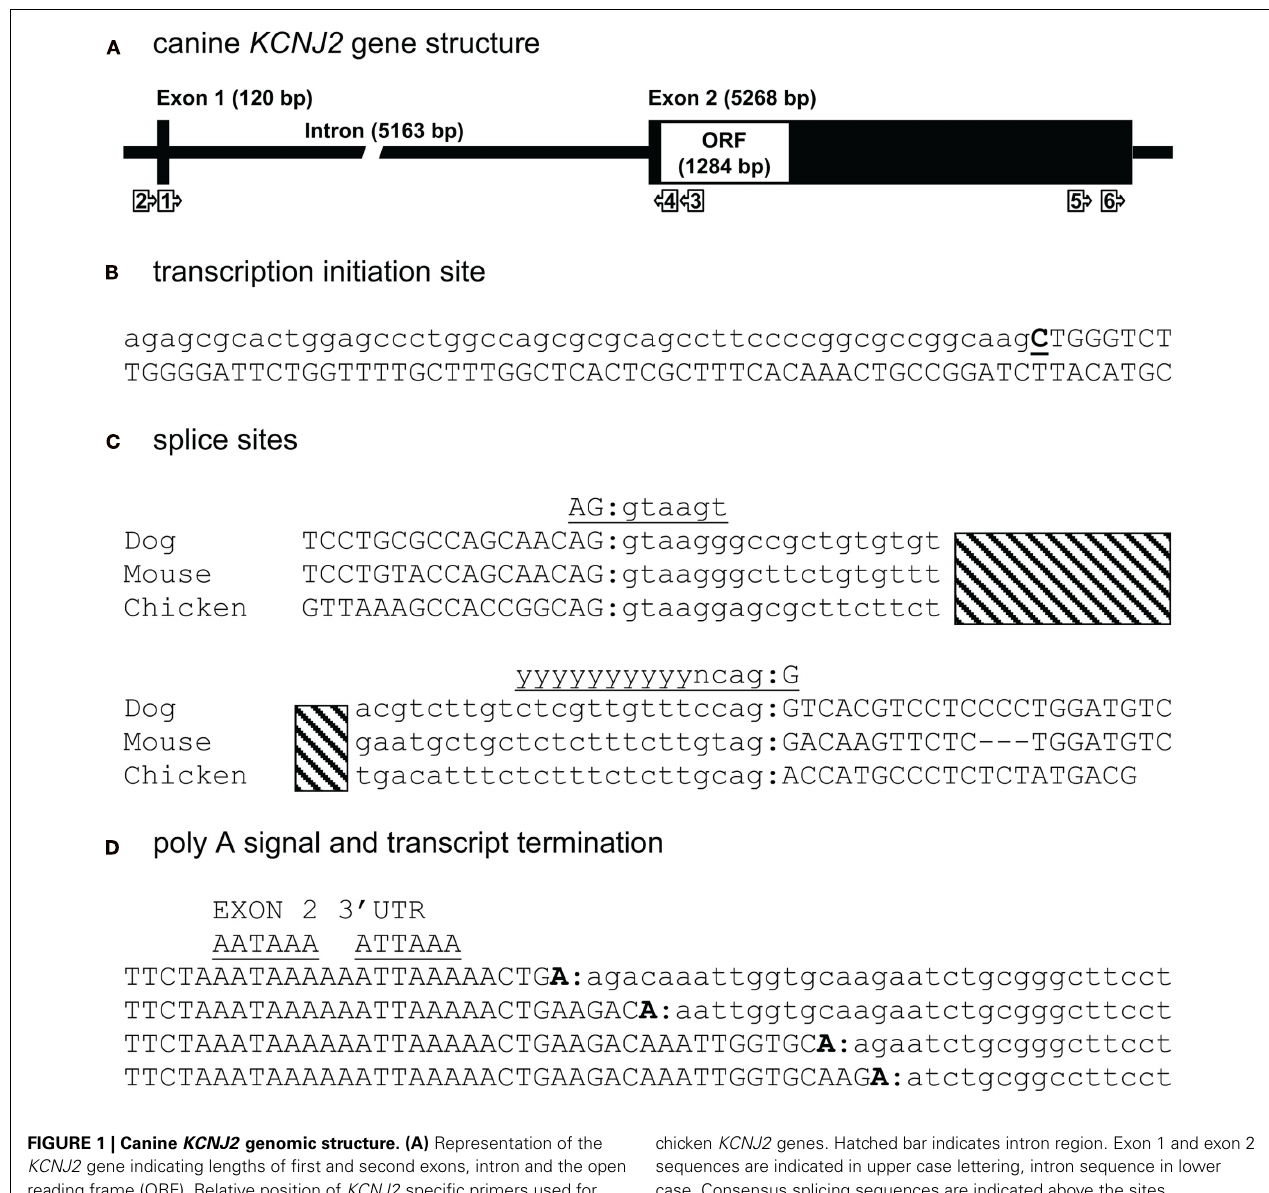
FIGURE 1 | Canine KCNJ2 genomic structure. (A) Representation of the KCNJ2 gene indicating lengths of first and second exons, intron and the open reading frame (ORF). Relative position of KCNJ2 specific primers used for intron/exon mapping, 5 (cid:2) and 3 (cid:2) RACE are indicated by numbered box arrows. (B) Transcription initiation site (bold and underlined) with upstream (lower case) and downstream exon 1 (upper case) sequences. (C) Sequence surrounding exon 1–intron and intron–exon 2 splicing sites of dog, mouse, and